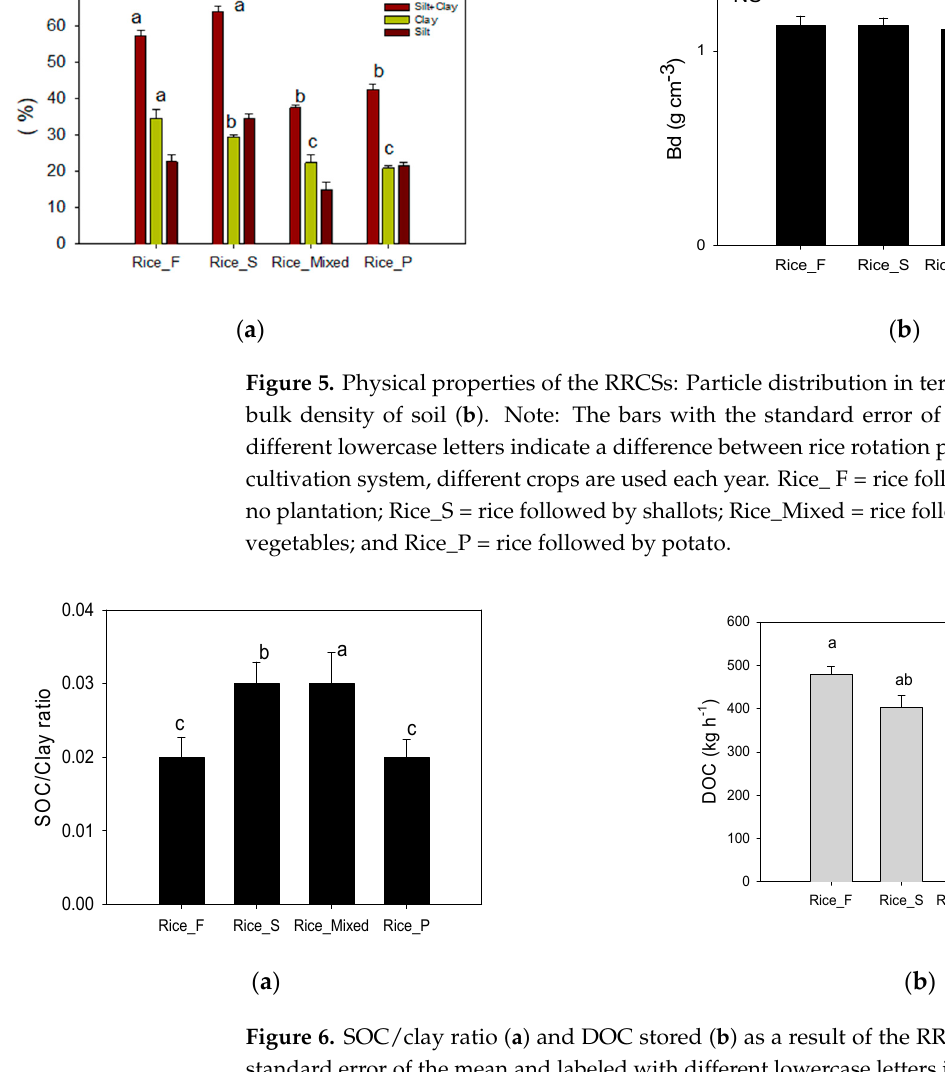
Figure 7. Carbon storage under an individual RRCS at a depth of 0–30 cm. Note: The difference in lowercase letters means that the treatments differ significantly ( p < 0.05) with the standard error above the bar. 3.5. Relations of SOC and Labile Carbon and Soil Carbon Storage under the RRCS Pearson’s Correlation between SOC Storage and Physicochemical Properties The SOC with labile carbon fractions was found to be highly positively correlated with carbon storage. In some physicochemical properties, clay and CEC showed good agreement with carbon storage. Meanwhile, a positive relationship existed between SOC and the labile carbon; between DOC and POXC; and between pH and P, K, clay, silt, and